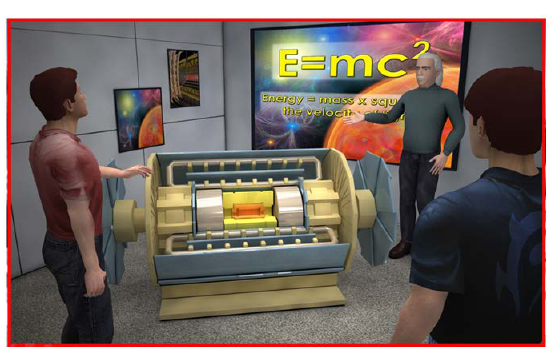
Figure 10. Virtual world Lab showing Einstein avatar giving lecture on particle physics